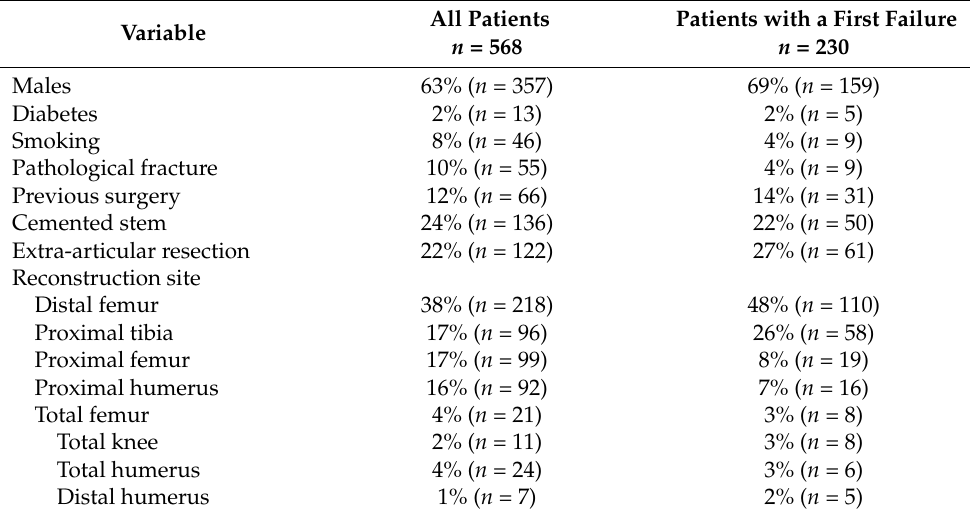
Table 1. Patient demographics and surgical details for all patients excluding local tumor progression as a first failure mode, patients with a first failure excluding patients who underwent amputation for the first failure and patients with a second failure.